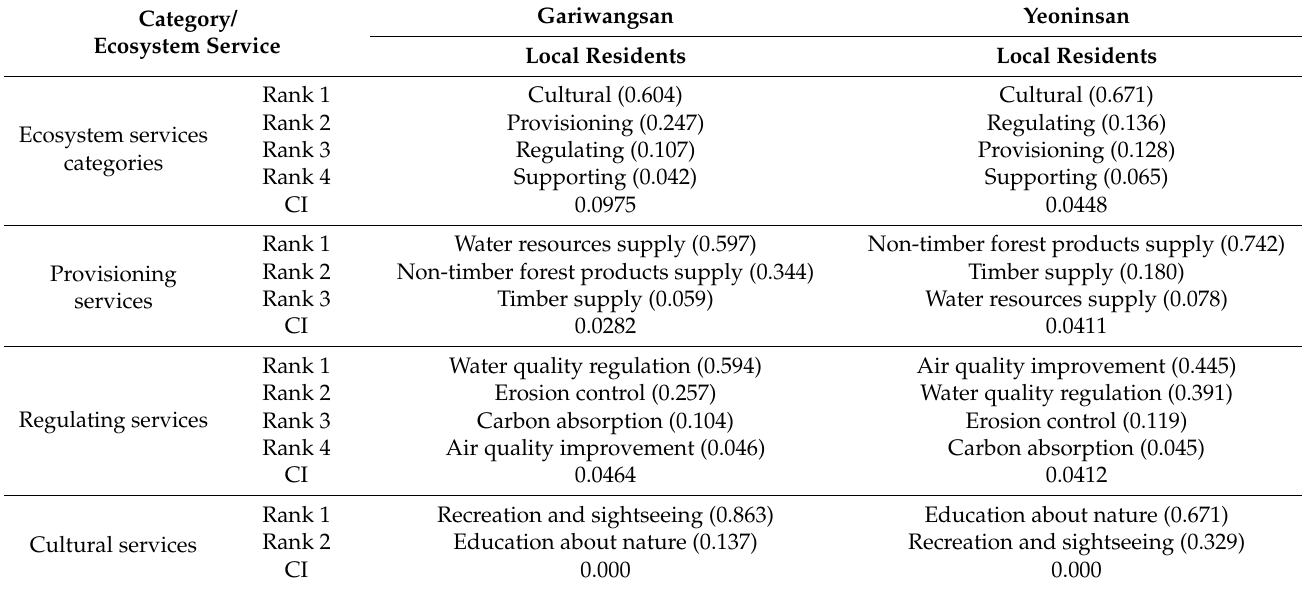
Table 4. Ranking of the ecosystem services in accordance with the local residents’ responses.